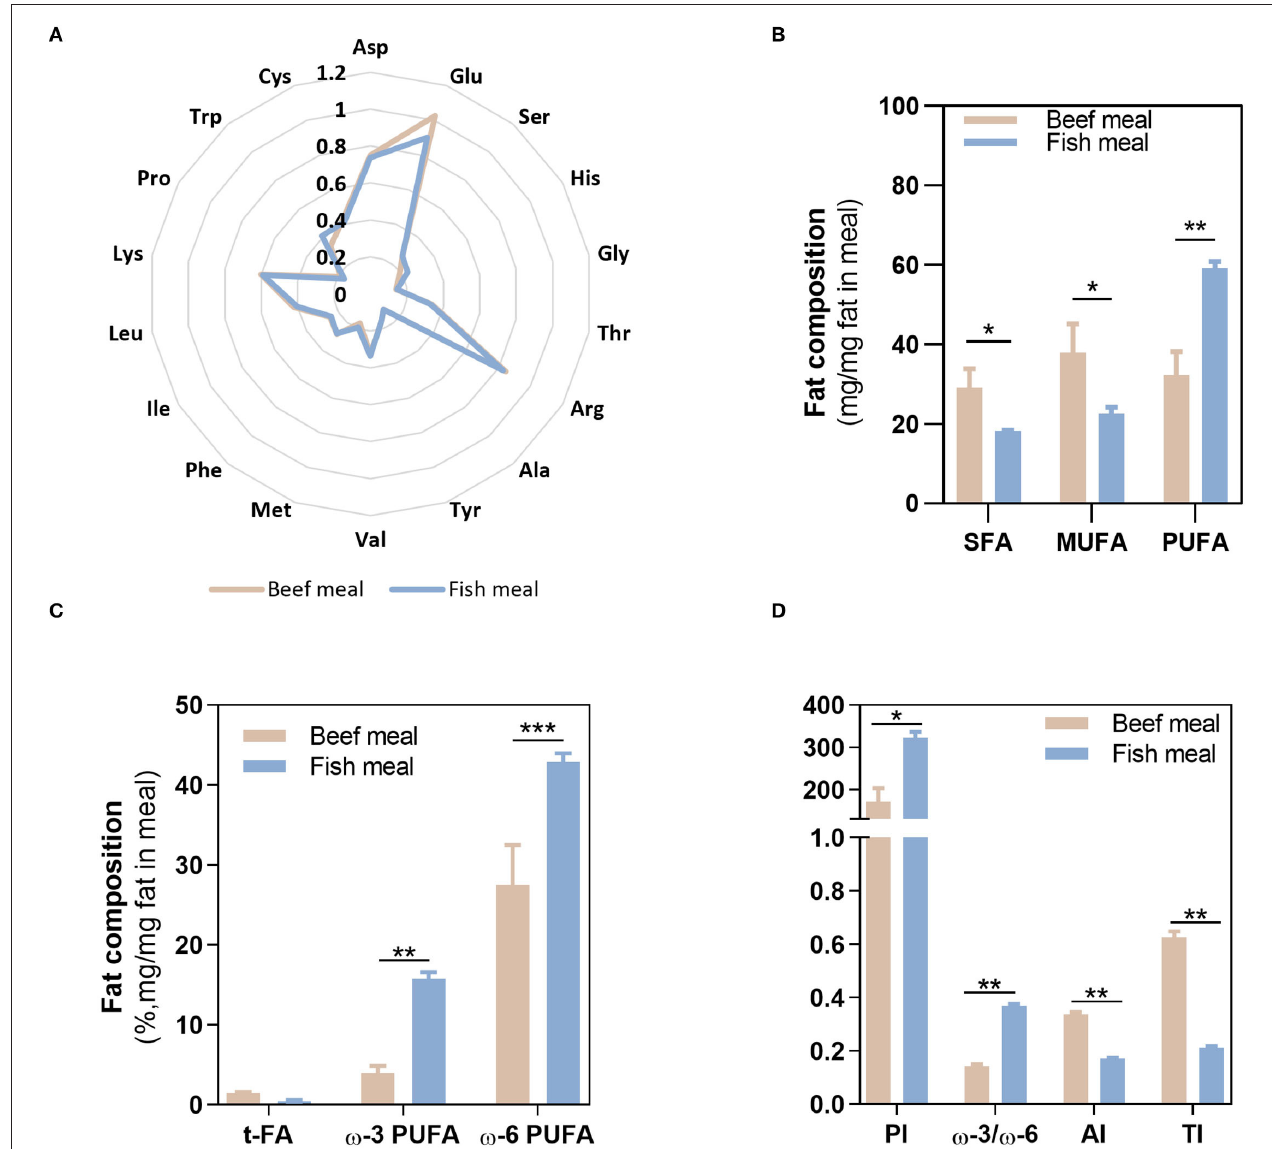
FIGURE 2 | Fatty acids and amino acids profile. Composition of beef and fish meal diets concerning their amino acid profile (A) , fatty acid profile (B,C) , and meals quality indexes (D) . Asp, aspargine; Glu, glutamic acid; Ser, serine; His, histidine, Gly, glycine; Thr, threonine; Arg, arginine; Ala, alanine; Tyr, tyrosine; Val, valine; Met methionine; Phe, phenylalanine; Ile, isoleucine; Leu, leucine; Lys, lysine; Pro, proline; Trp, typtophan; Cys, cysteine; SFAs, saturated fatty acids; MUFA, monounsaturated fatty acids; PUFA, polyunsaturated fatty acids; t-FA, trans-fatty acids; PI, peroxidisability index; AI, atherogenic index; TI, thrombogenic index. * p < 0.05, ** p < 0.01, *** p <